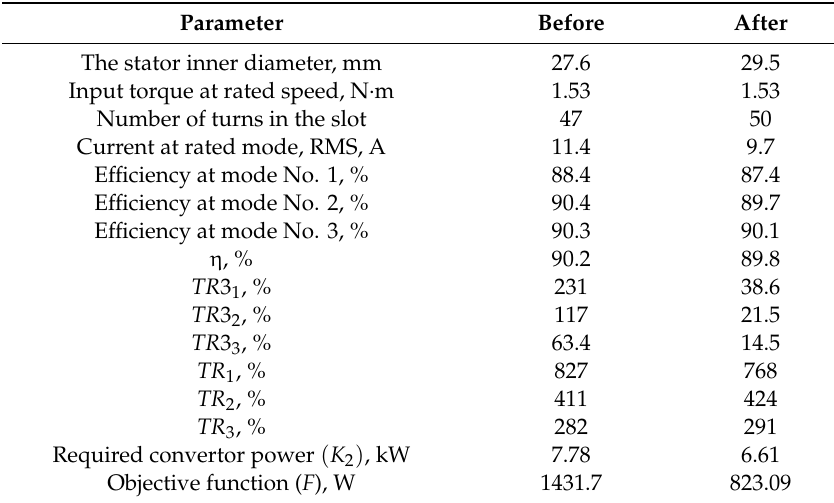
Table 3. FRM characteristics before and after optimization.